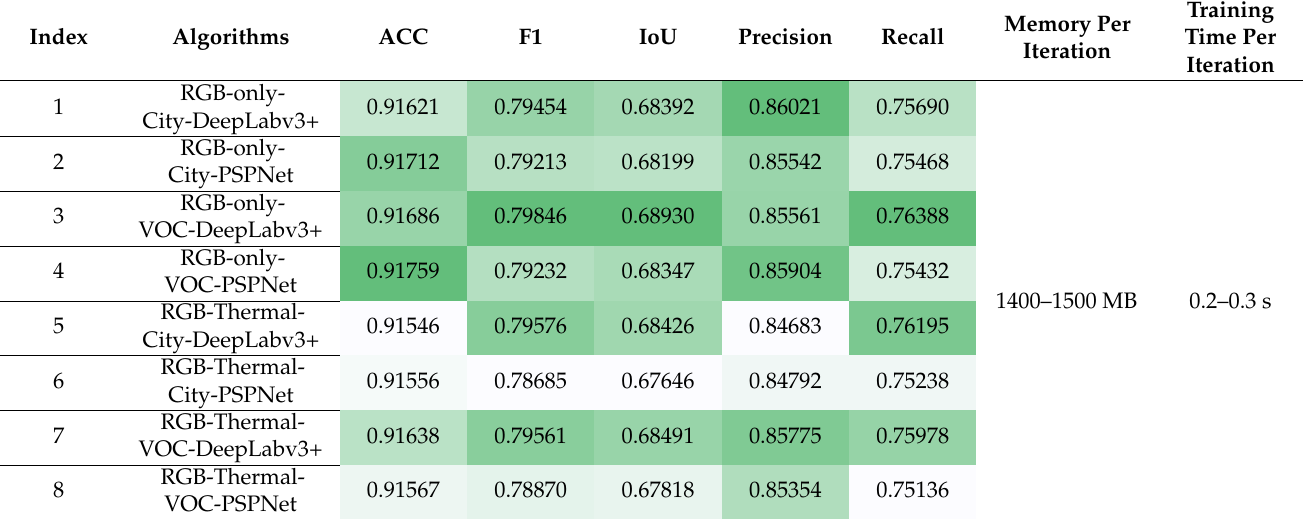
Table 3. Performance evaluation of PSPNet and DeepLab v3+.